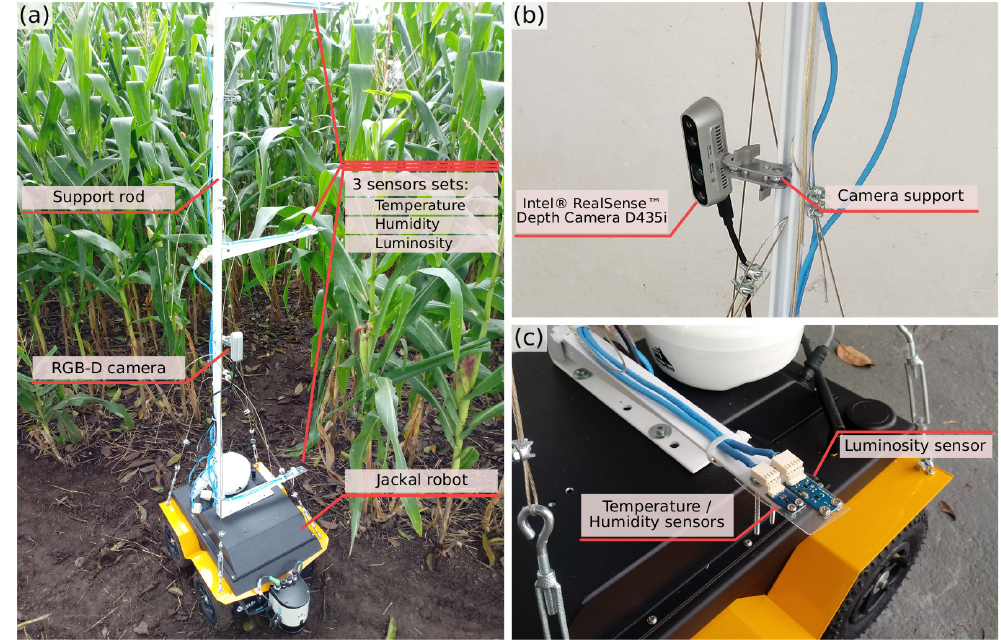
Figure 2. Proposed terrestrial acquisition module. ( a ) Overview; ( b ) RGB-D camera; and ( c ) sensor